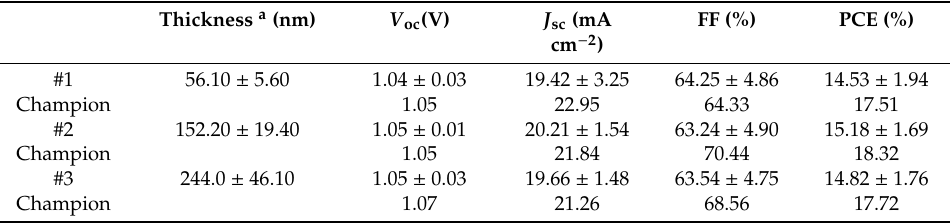
Table 1. Photovoltaic parameters of the assembled planar PSCs with a typical configuration of FTO / TiO 2 / MAPbI 3 / Spiro-MeOTAD / Ag.